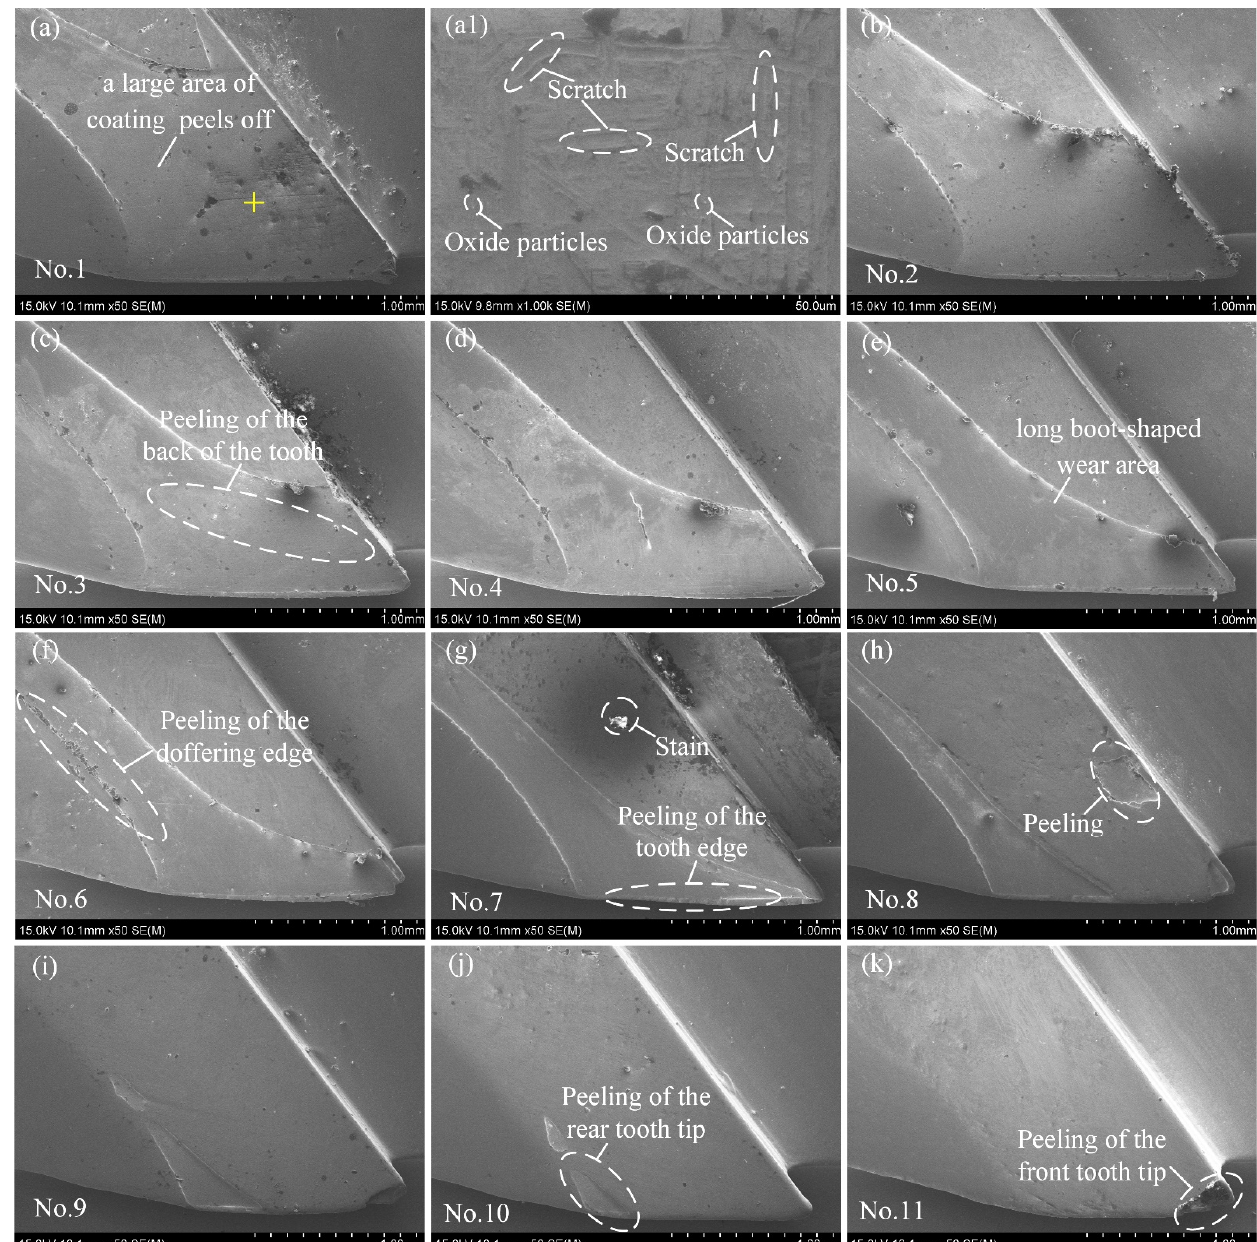
Figure 10. Wear morphology of hook teeth nos. 1 to 11 in a 600-hectare operation: ( a – k ) Wear morphology of hook teeth nos. 1 to 11; and ( a1 ) partial micrograph of the hook tooth nos. 1 mark. In sum, the wear of the spindle hook teeth starts from their front and rear tips before extending to their edges and back and then extending backward along the doffering edge to form a long boot-shaped wear area. Compared with hook teeth nos. 7 to 12, nos. 1 to 6 are more easily worn. The analysis results reveal that in the process of picking cotton, the hook teeth insert themselves into the cotton to hook the material, and given that the front and rear tooth tips are relatively sharp and the stress is concentrated, the front and rear tooth tips tend to be the first to wear out. In the process of picking cotton, the hook teeth are constantly in contact with cotton fibers, cotton rods, and bell shells, and the coating on the edges and back of the teeth is prone to abrasive wear and even fatigue peeling [24]. During the doffing process